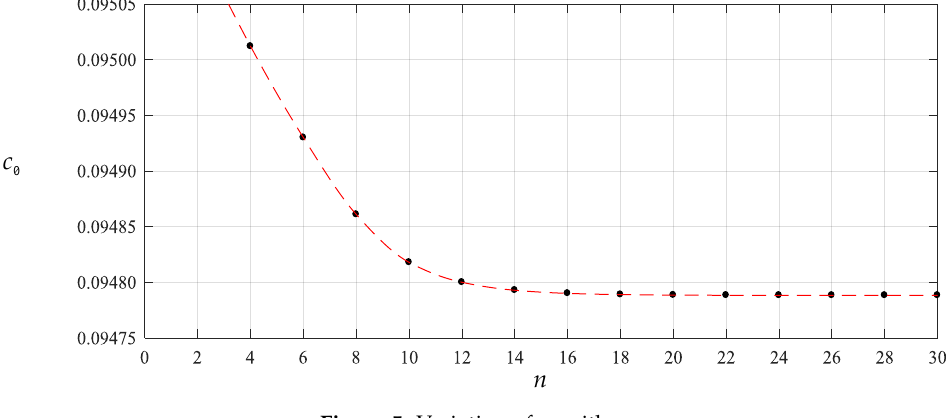
Figure 5 . Variation of Figure 5. Variation of c 0 with n .